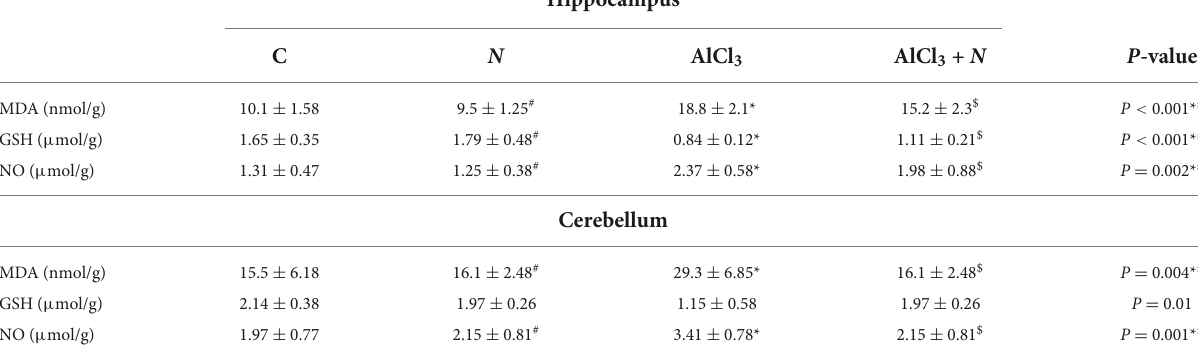
TABLE 2 Effects of naringin administration on MDA, NO, and GSH levels in hippocampal and cerebellar